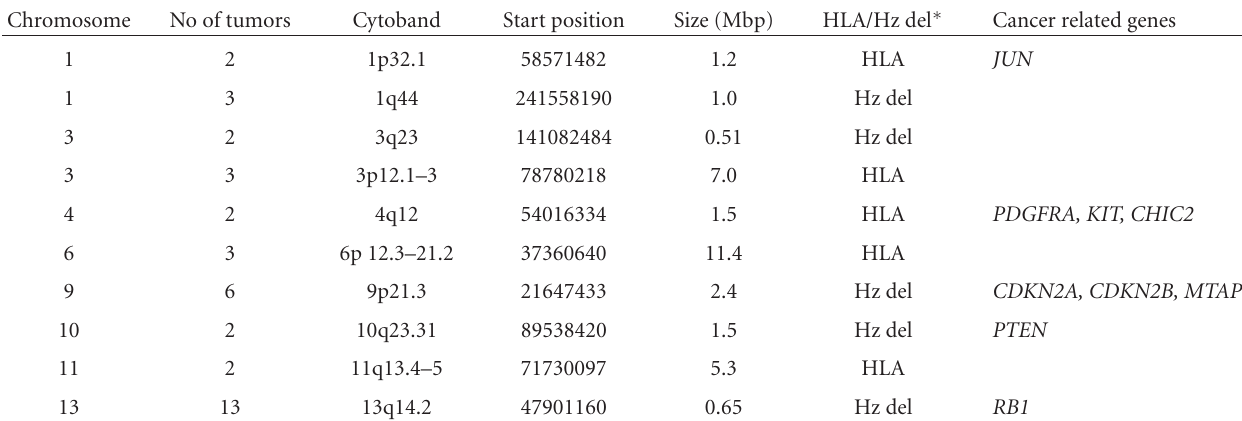
Table 2: Recurrent high-level amplifications and homozygous